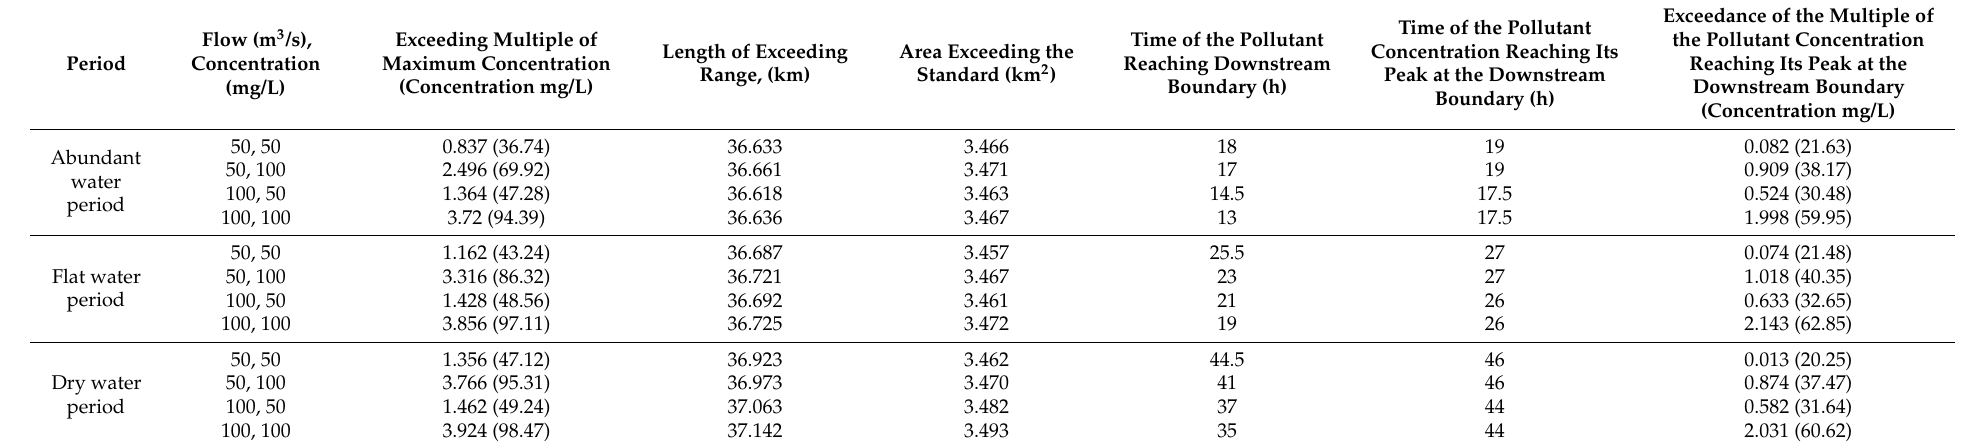
Table 1. Heavy metal iron early warning indicator values in high-flow, level, and low-flow